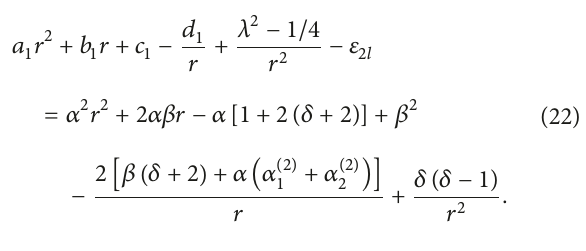
For the second node (𝑛 = 2) , we use 𝑓 2 (𝑟) = (𝑟−𝛼 and 𝑔 𝑙 (𝑟) from (13) to solve (15) which